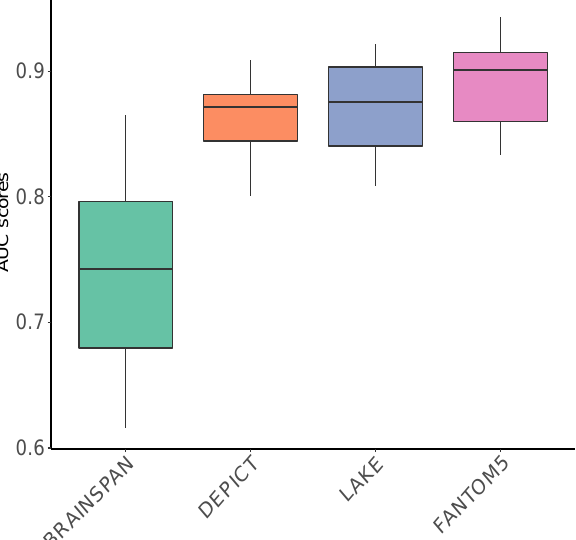
Figure 2. Distribution of AUC scores across the predictions from different features. The average AUC of 0.74, 0.86, 0.87, and 0.89 were obtained from BRAINSPAN, DEPICT, LAKE, and FANTOM5, respectively.